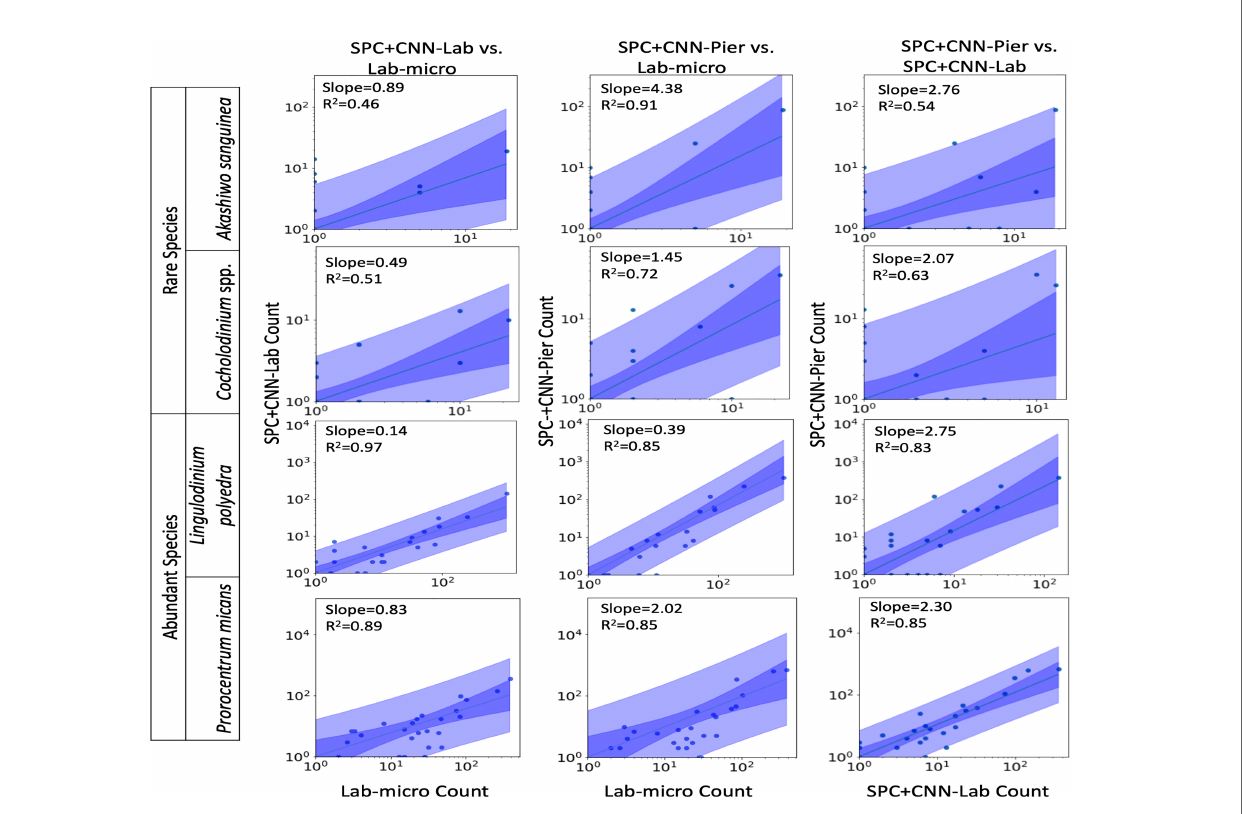
FIGURE 8 | Relationships between counts of Lab-micro and SPC+CNN methods. Columns highlight pairs of counting methods, rows demarcate species. The solid line indicates a linear regression model that is coupled with multiple shaded areas indicating the 95% prediction (dark shade) and con fi dence interval (light shade). The slope and R 2 of the model fi t are indicated. Note that data is displayed logarithmically but was fi t